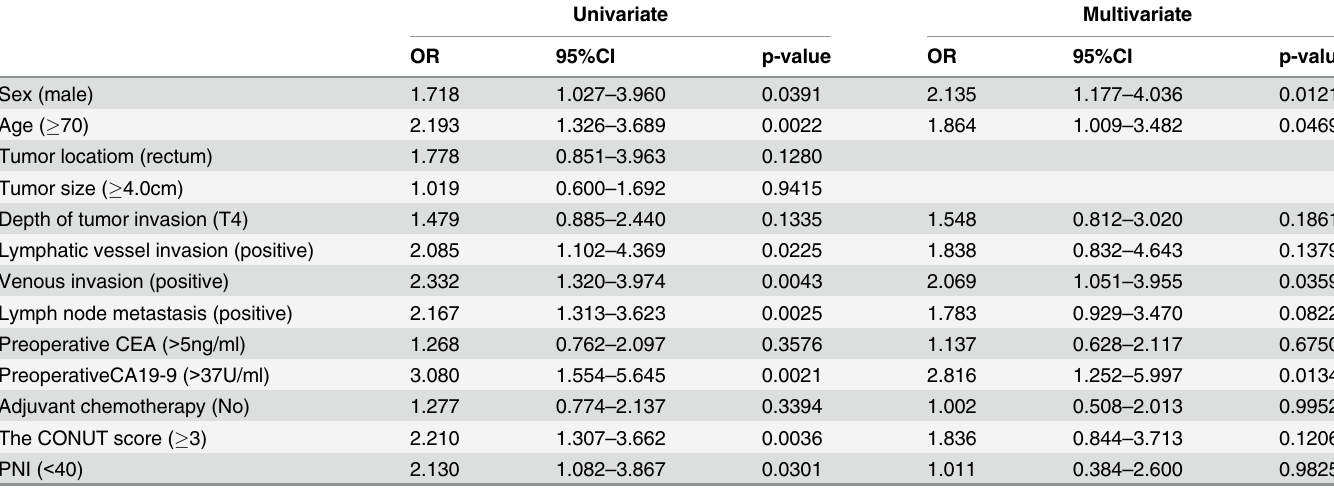
Table 4. The results of the univariate and multivariate analyses of the prognostic factors for the relapse-free survival